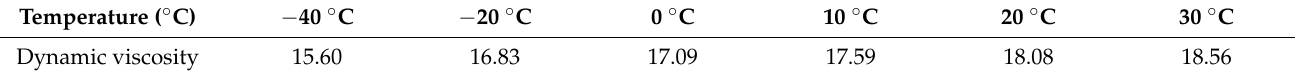
Table 5. Dynamic viscosity of air ( µ Pa · s).